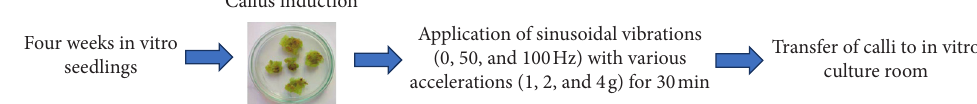
Figure 1: Depiction of application of vibration and acceleration treatments on A. gilanica Table 1: Effect of different sinusoidal vibrations (0, 50, and 100Hz) and accelerations (1, 2, and 4g) on growth parameters, relative water content (RWC), protein, and total carbohydrate of two Anthemis gilanica callus sources. Callus source Vibration (Hz) Acceleration (g) Fresh weight (g/plant) Dry weight (g/plant)